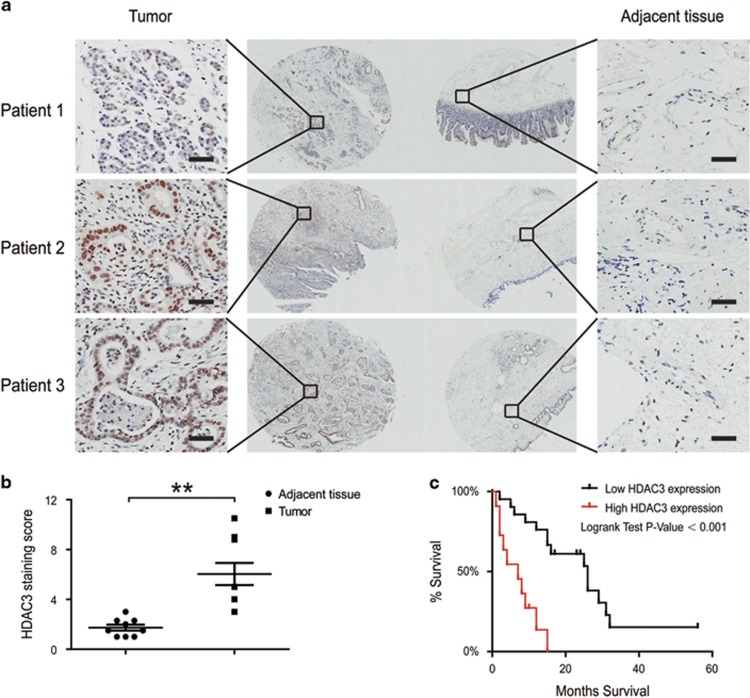
HDAC3 expression was increased in CCA tissues. (a and b) HDAC3 protein levels in tumor and adjacent normal tissues from nine CCA patients were detected (top) and quantified (bottom). The magnification is x200. Scale bars, 100 μm. (c) The 5-year survival was reduced for CCA patients with elevated HDAC3 protein expression. Data represent the mean±S.E.M., n≥3. *P<0.05 and **P<0.01